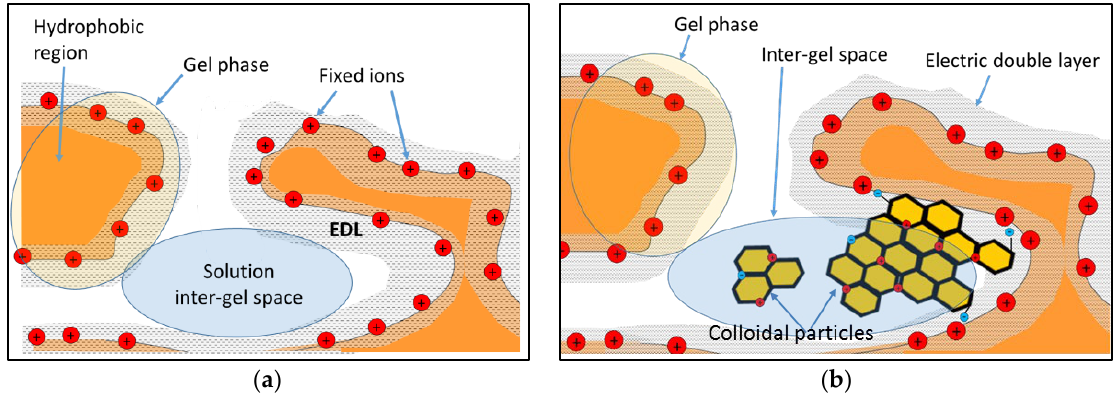
Figure 22. Schematic IEM structure represented in terms of microheterogeneous model [68] ( a ) and the same model, which considers colloidal particles ( b ) formed by polyphenols. EDL is the electric double layer. Adapted from [41].